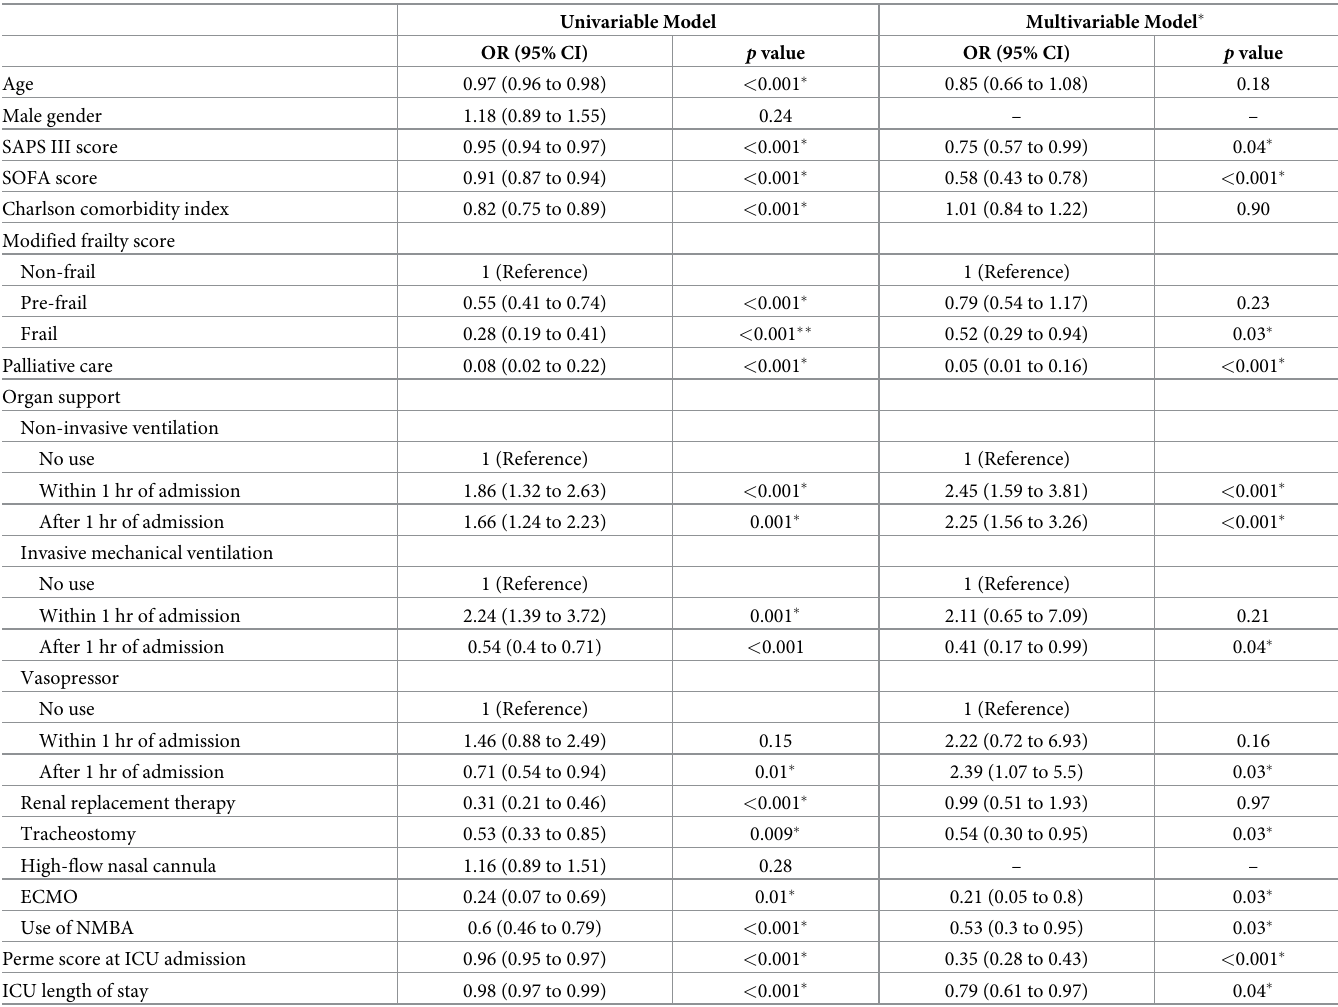
Table 2. Univariable and multivariate logistic regression analysis addressing risk factors associated with patients’ that improved mobility level (n = 949